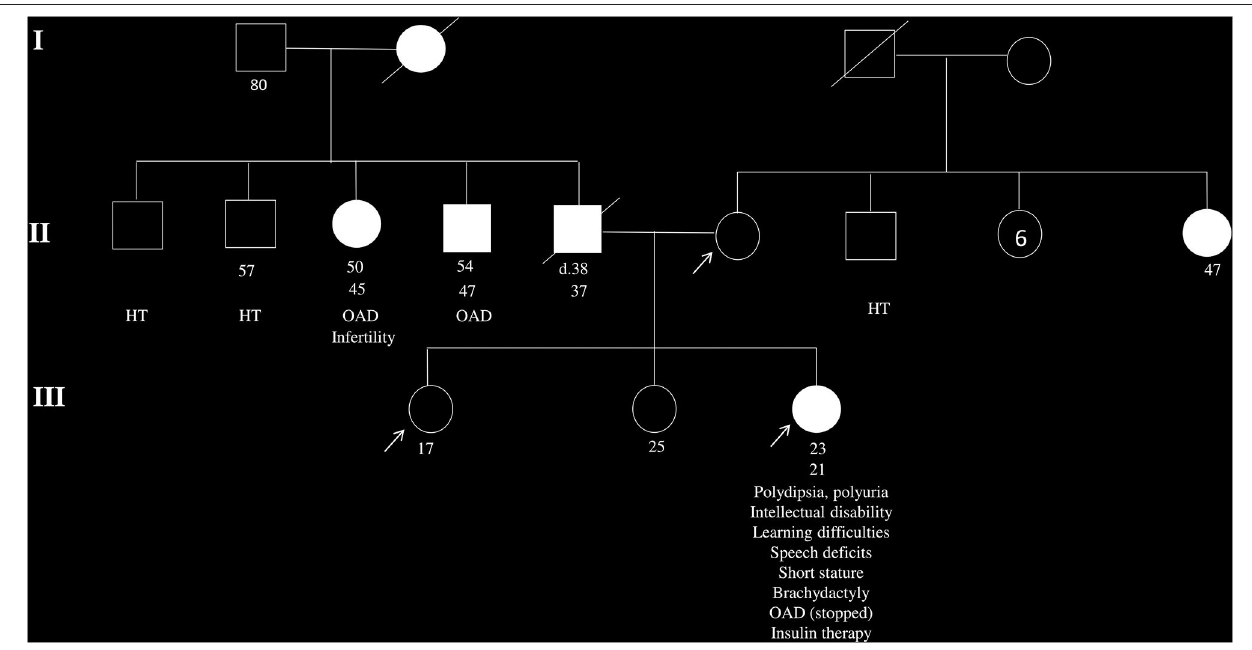
FIGURE 1 | Pedigree of the family of the patient with clinical suspicion of maturity-onset diabetes of the young (MODY). The arrows indicate the patient and her non-diabetic mother and young sister, whose DNA samples are available in the present study. White squares and circles indicate healthy males and females, respectively. Black squares and circles indicate males and females with diabetes. Information below family members is ordered as follows: age at examination, age at diabetes diagnosis, clinical features, and/or specific anti-hyperglycemia treatment. OAD, oral antidiabetics; HT,